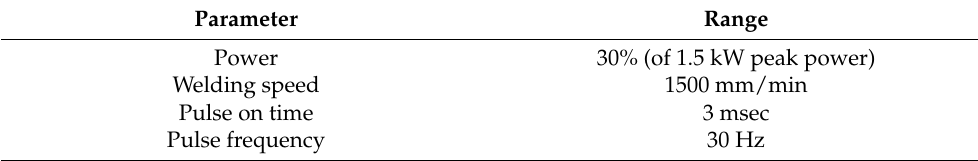
Table 4. Laser welding process parameters used in this